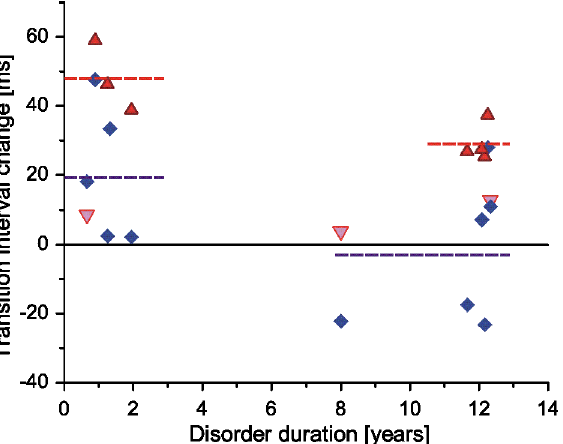
Fig 3. Distance Δ TI for less- and more-affected MNs, plotted vs. disorder duration. Explanation of symbols as in Fig 2, except for 3 outliers of more-affected MNs for patients older than 55 years (triangles down). Dashed horizontal lines indicate mean values of Δ TI for short and long time after